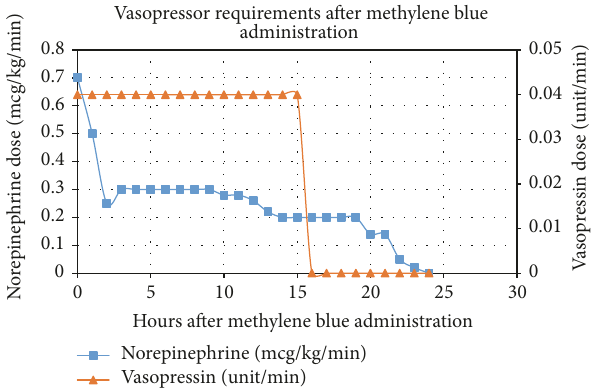
Figure 1: Vasopressor requirements hours after methylene blue